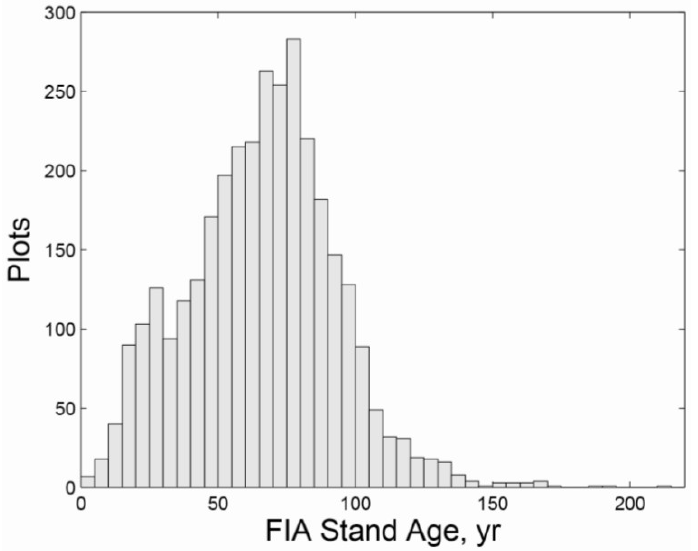
Figure 5. Regional age-class distribution of stand age in the U.S. Forest Inventory and Analysis (FIA) plot